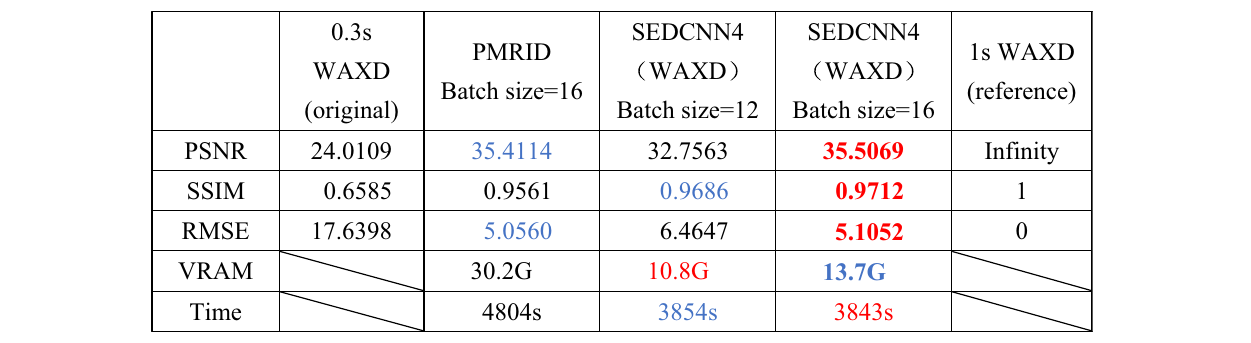
Red colored values indicate best performer while blue ones indicate second best performer. The bold red colored values indicate the best performer in terms of the performance metrics frequently used in the